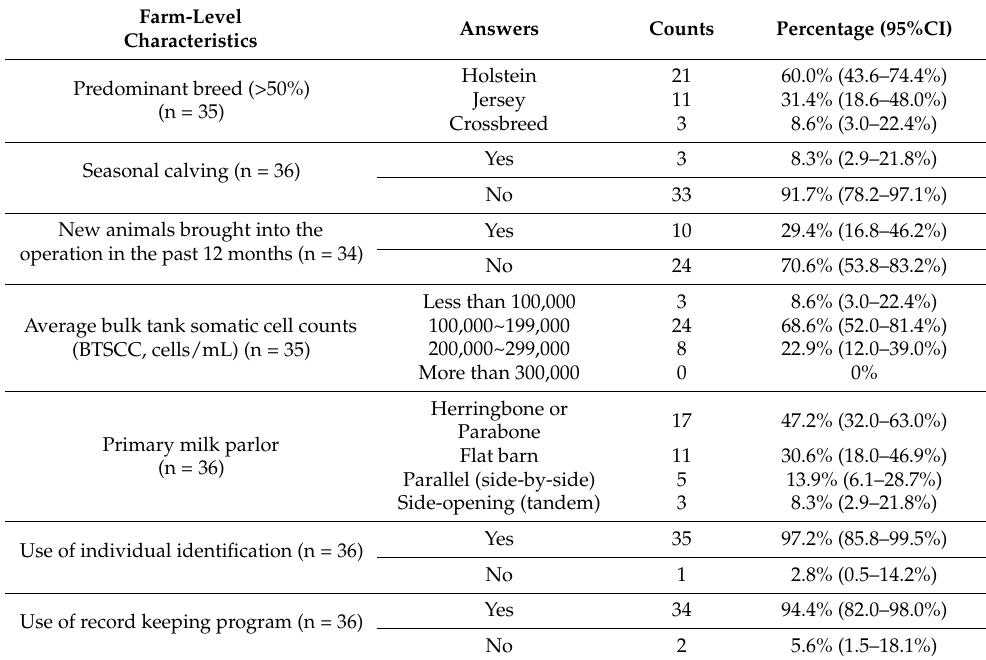
Table 1. Demographics of organic dairy farms in CA (n = 36 farms